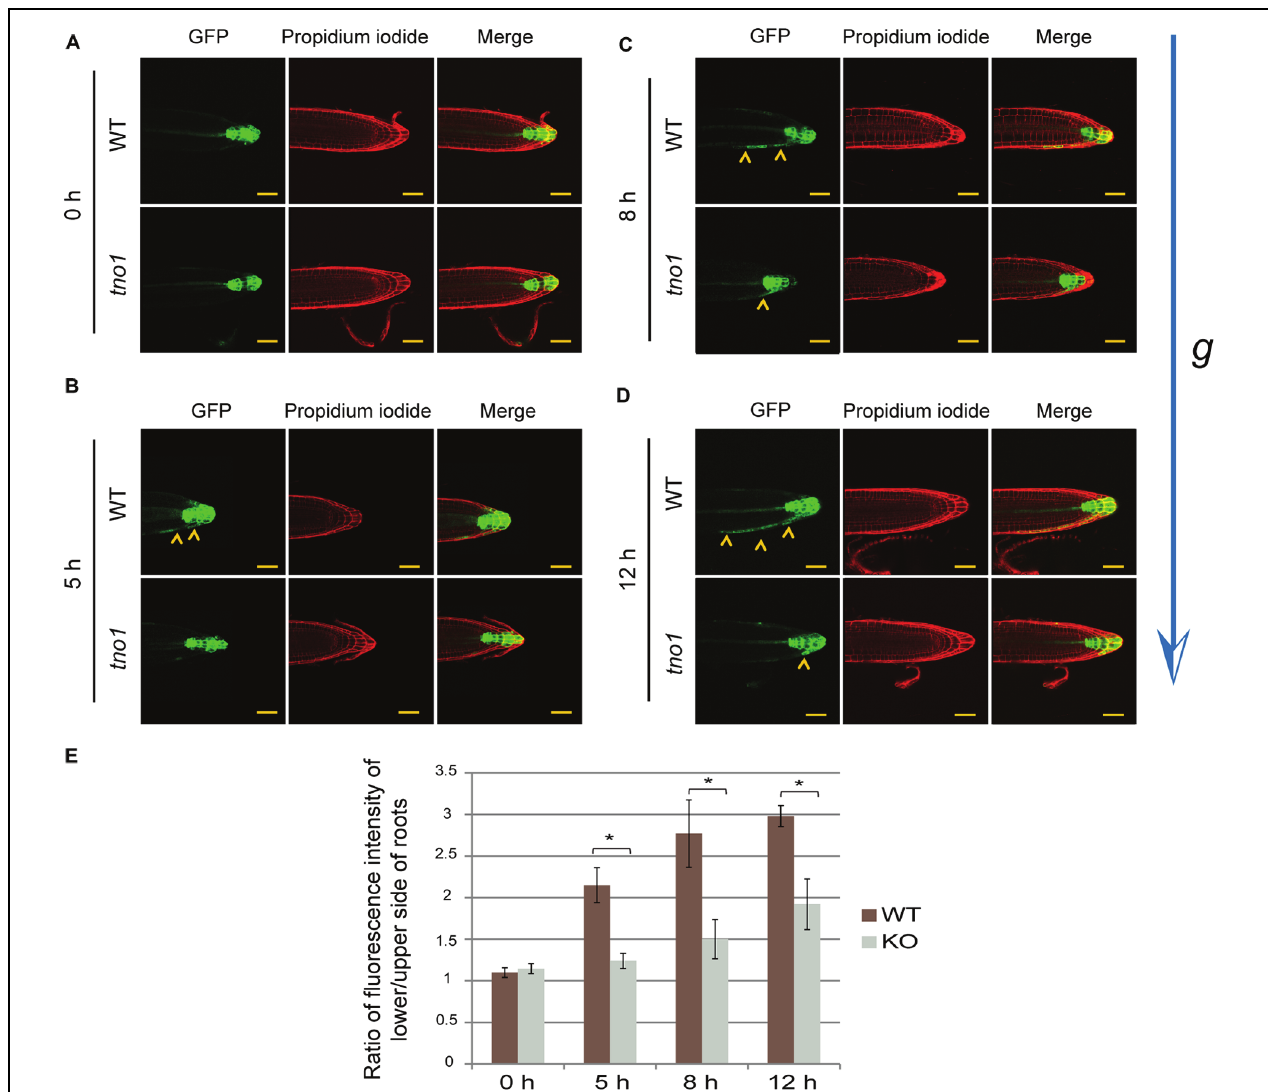
FIGURE 5 | tno1 mutants have delayed auxin responses in epidermal cells in gravistimulated roots. Representative confocal images of mutant and WT primary root tips showing DR5rev:GFP expression under (A) vertical (non-gravistimulated condition), (B) 5 h gravistimulation, (C) 8 h gravistimulation, and (D) 12 h gravistimulation. Yellow arrowheads indicate auxin reporter expression expanding from columella to epidermal cells of the elongation zone. Scale bar = 50 µ m. (E) Quantification of DR5rev :GFP asymmetry as a ratio of fluorescence intensity on the lower and upper flanks of gravistimulated roots at the indicated time points. Values are means from analysis of 10 roots for each time point and error bars indicate standard errors. Similar letters indicate no statistical difference while different letters indicate a statistically significant difference ( P < 0.05) by Student’s t